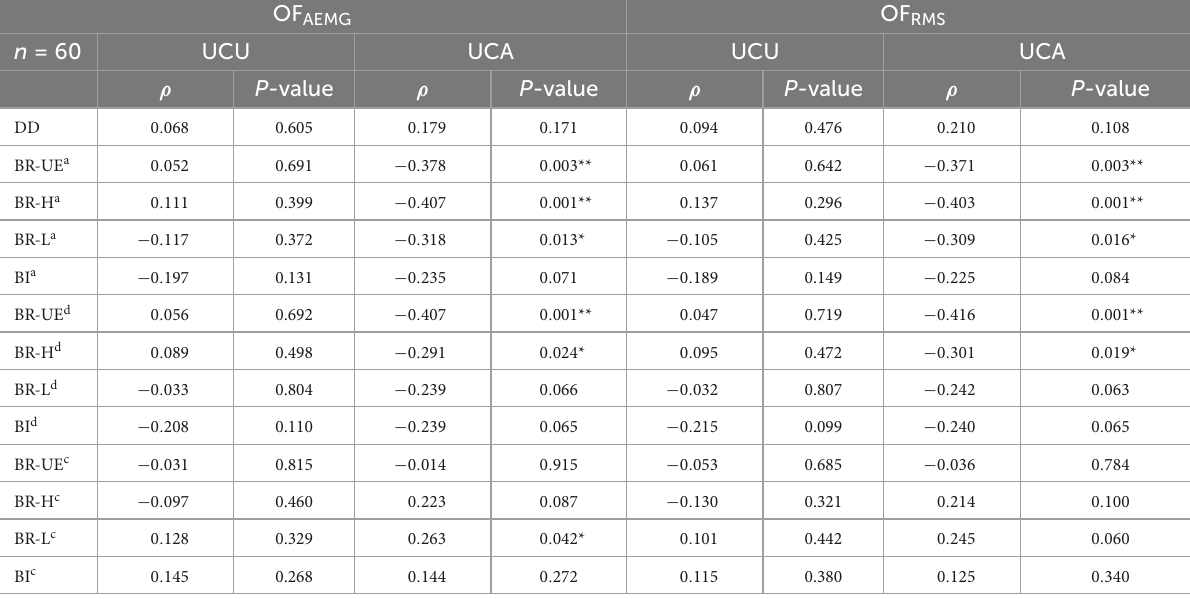
TABLE 3 Spearman correlation coefficients ( ρ ) for OF and clinical assessments.